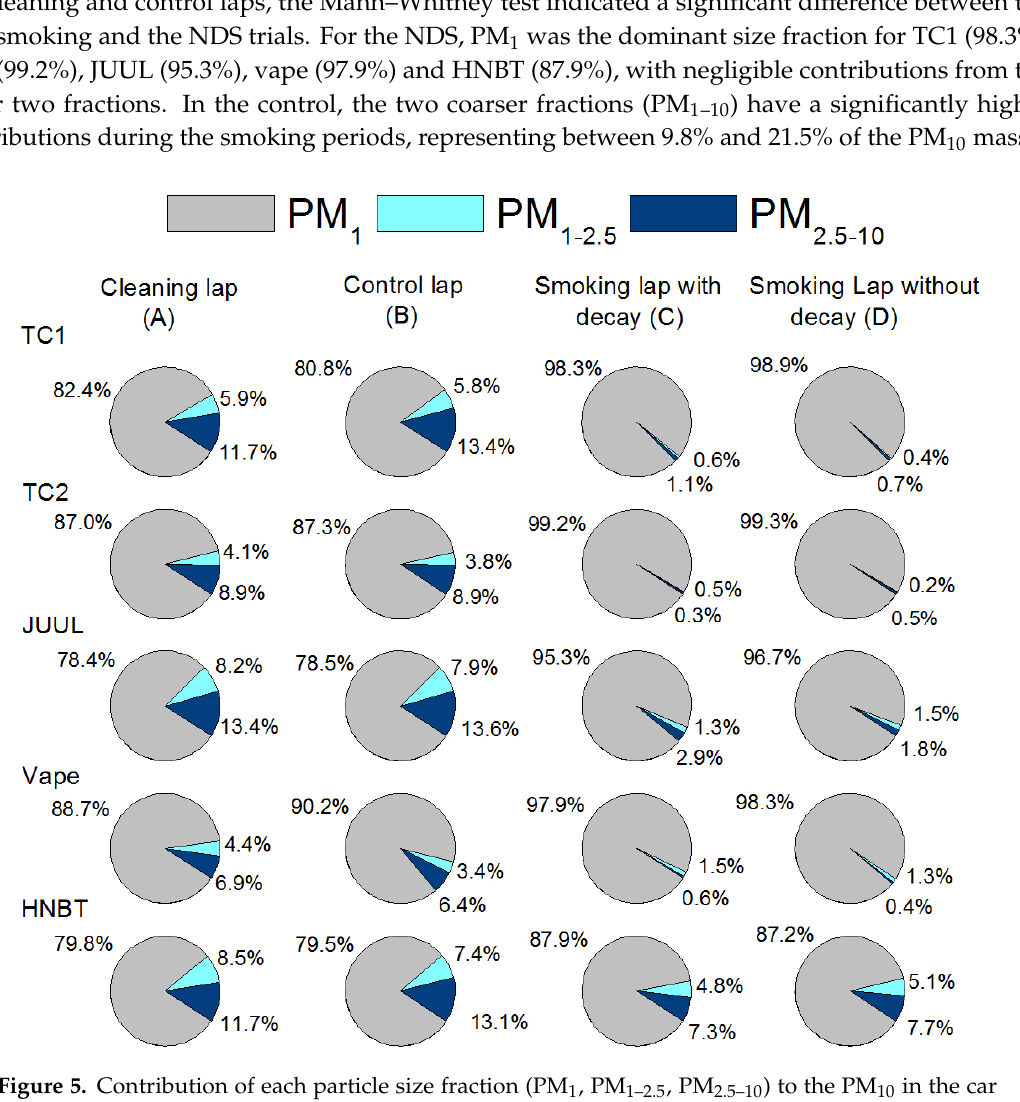
Figure 5. Contribution of each particle size fraction (PM 1 , PM 1–2.5 , PM 2.5–10 ) to the PM 10 in the car discriminated by NDS.